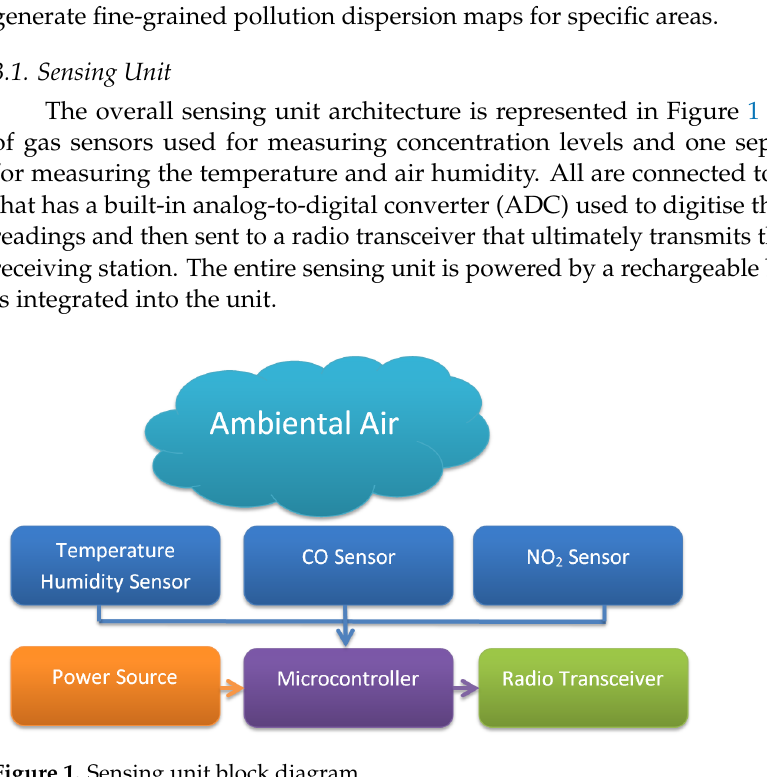
Figure 1. Sensing unit block